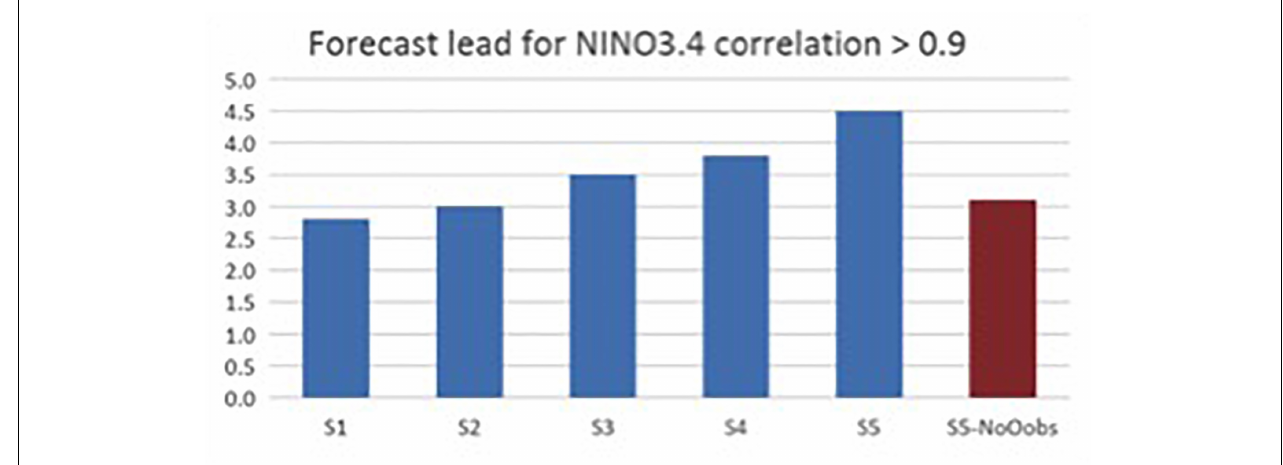
FIGURE 1 | Lead time in months at which NINO3.4 SST anomaly correlation drops below 0.9 over the period 1987–2002. Results are given for five generations of seasonal forecasting systems at ECMWF (S1–S5). A version of SEAS5 without ocean data assimilation (SEAS5-NoOobs) is given for reference from Stockdale et al.